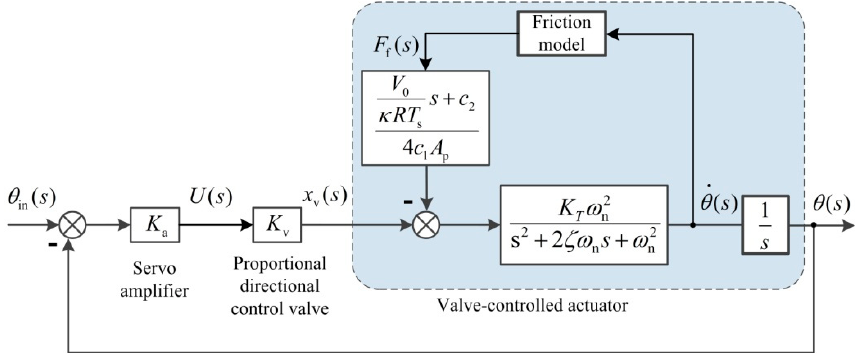
Figure 6. Block diagram of the pneumatic rotary actuator servo system.